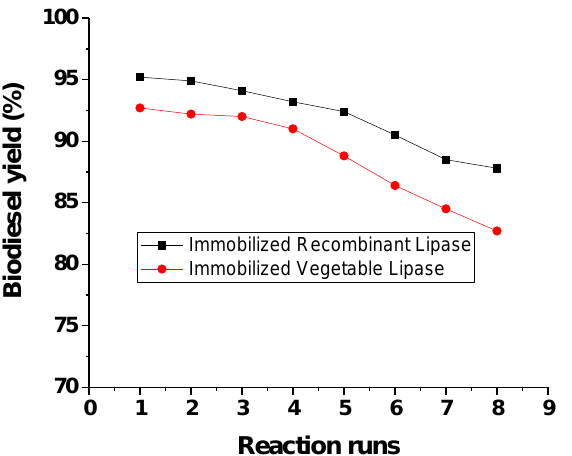
Figure 8. Catalyst reusability evaluation in 8 reaction cycles. Reaction condition: Jatropha curcas L. oil 10 g, ethanol-to-oil mass ratio 10, water content 9.1 wt%, immobilized lipase 5.25 g, mixing intensity 6 g RCF, temperature 35 ◦ C, pH value 7.5.